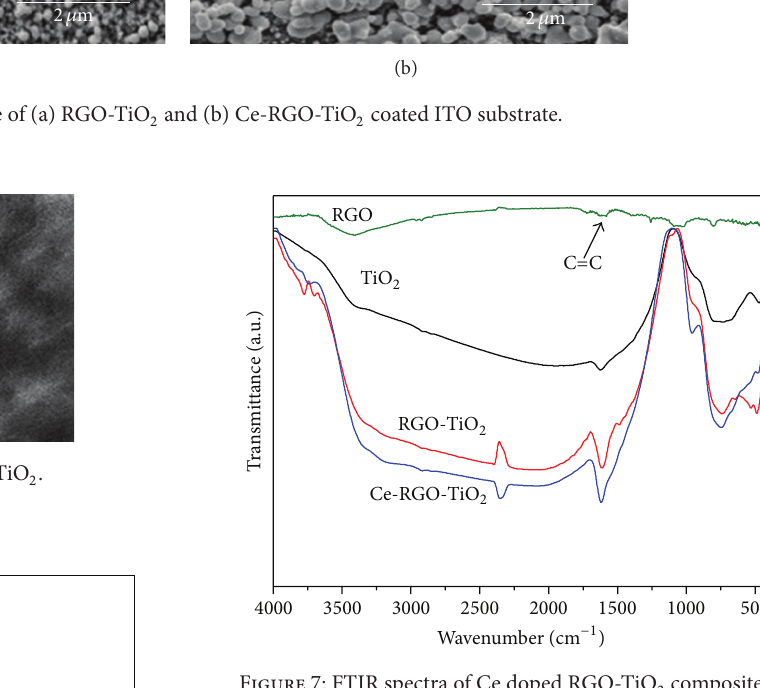
Figure 7: FTIR spectra of Ce doped RGO-TiO 2